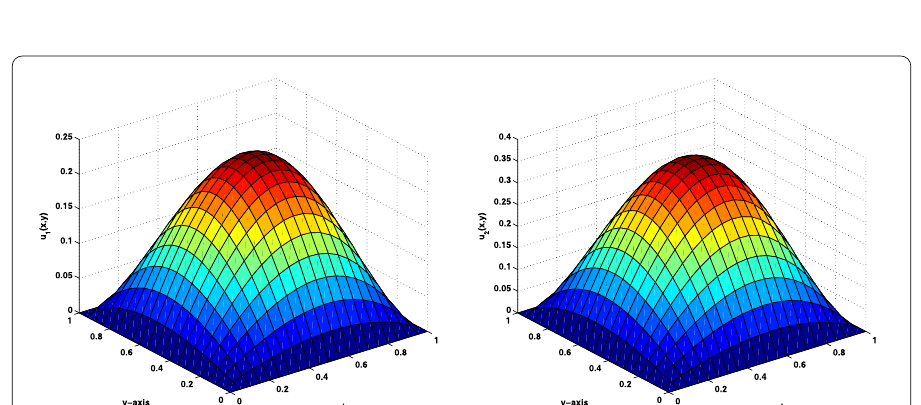
Figure 1 The exact solutions u 1 (Real part) and u 2 (Imaginary part) at t = 1